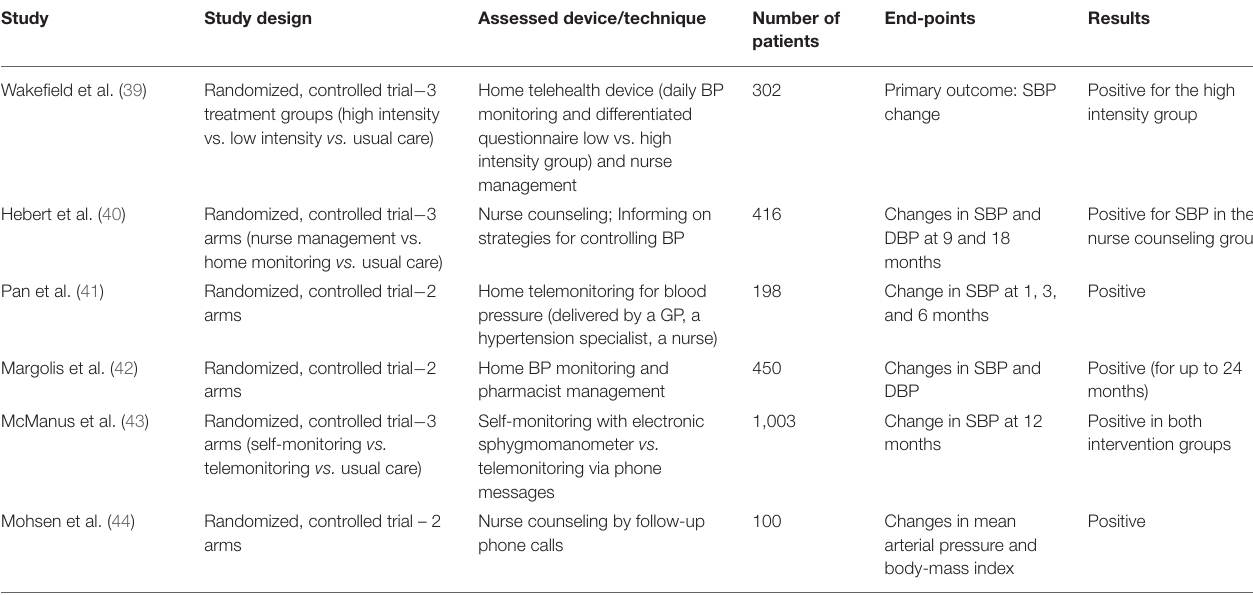
TABLE 3 | Summary of different hypertension telemedicine studies.